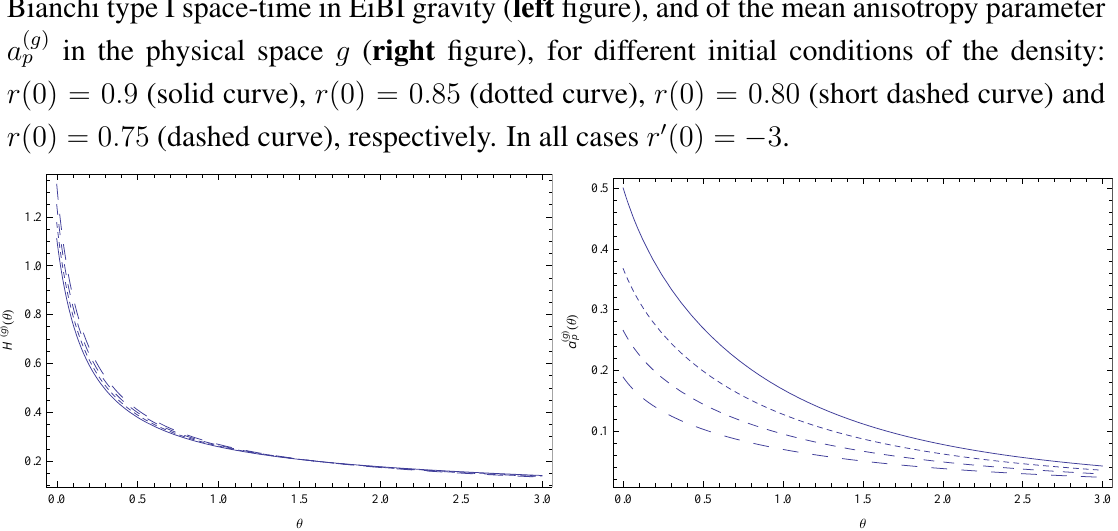
Figure 6. Time variation of the dimensionless Hubble function H ( g ) of the dust fluid filled Bianchi type I space-time in EiBI gravity ( left figure), and of the mean anisotropy parameter a ( g )